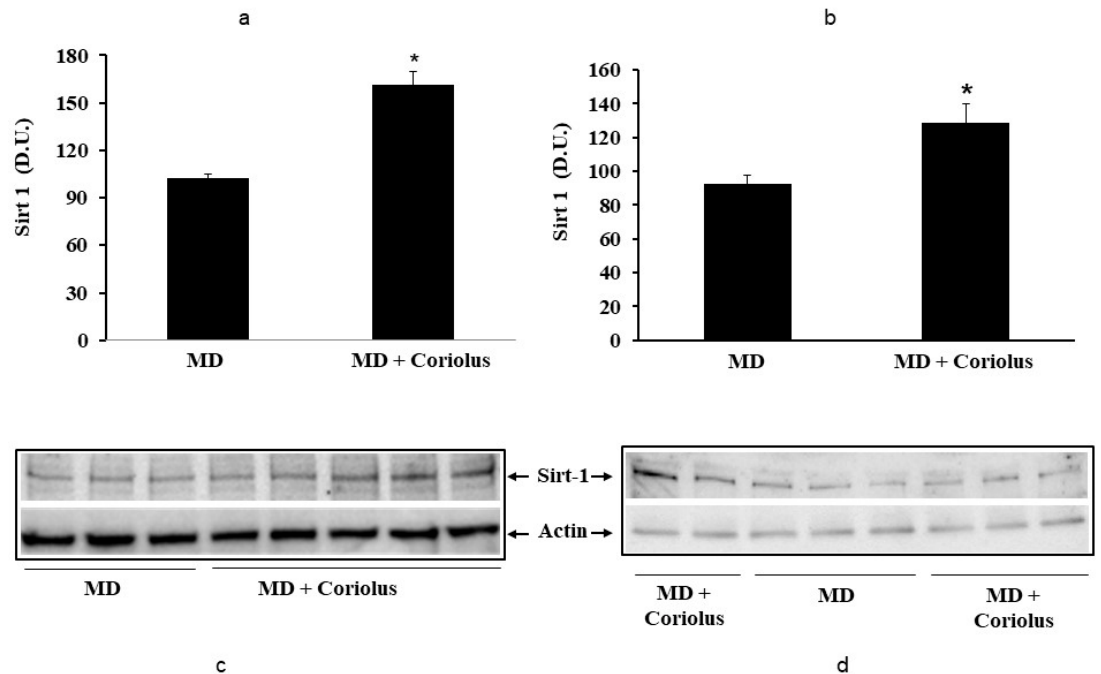
Figure 5. Levels of sirtuin-1 in lymphocytes ( a ) and plasma ( b ) from MD patients. Samples from MD patients were assayed for sirtuin-1 by Western blot as described in Materials and Methods. Representative immunoblots are shown in the same figure ( c , d ). β -actin has been used as loading control. The bar graph shows the densitometric evaluation and values are expressed as mean ± SEM of independent analyses on 22 patients (MD plus Coriolus biomass) and, respectively, on 18 patients (MD alone), per group. * p < 0.05 vs. MD alone. D.U., densitometric units.